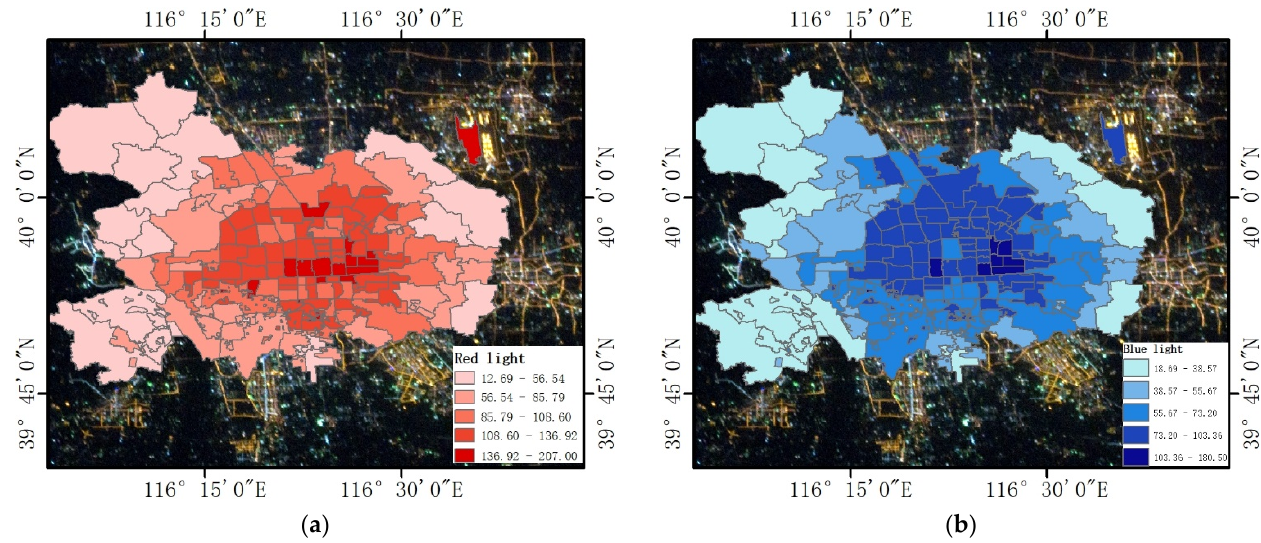
Figure 5. Classification results of red ( a ) and blue ( b ) light intensities by natural breaks method in the research area.